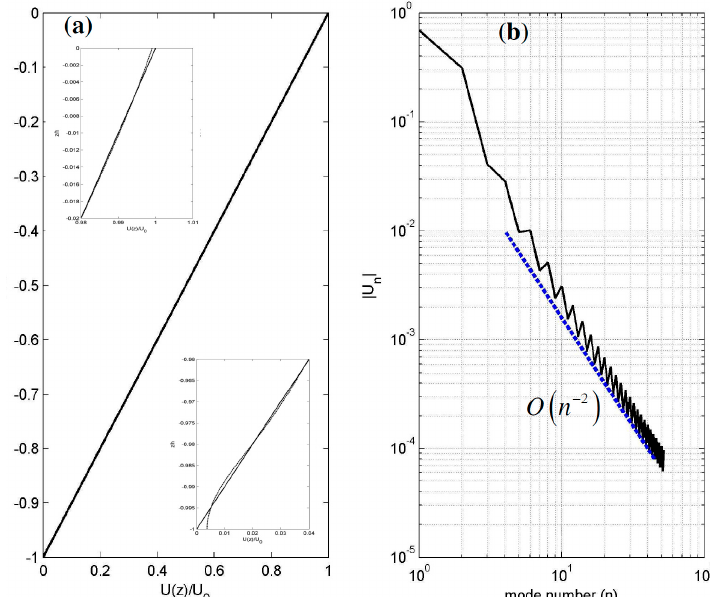
Figure A2. Modal representation of Couette flow between parallel planes at z / h = − 1 and z / h = 0. ( a ) Comparison of the present modal series defined by Equation (1), shown by using dashed lines, against the shear flow U ( z ) = U 0 ( 1 + z / h ) , shown by using solid lines. ( b ) Calculated rate of decay of the mode amplitudes | U n | . The asymptotic trend is indicated in the figure by using blue dotted lines.